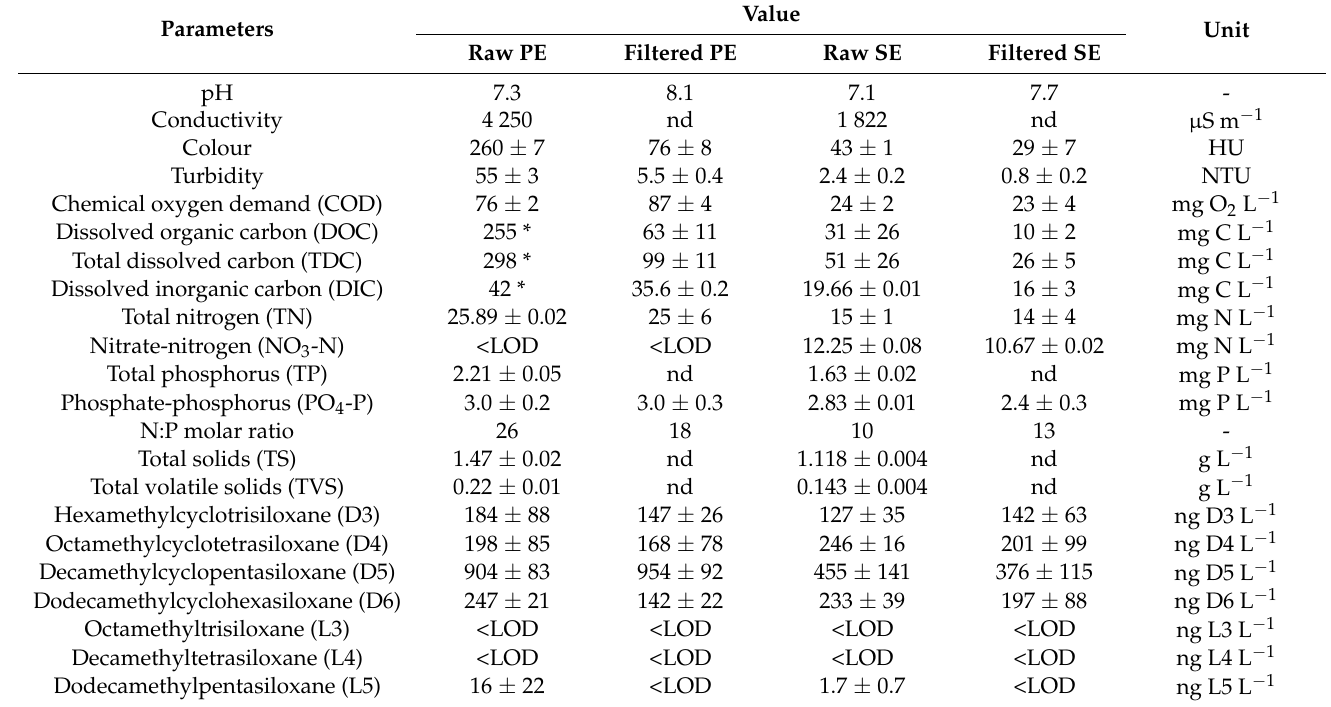
Table 1. Physicochemical characterisation of the raw and filtered effluents used in this